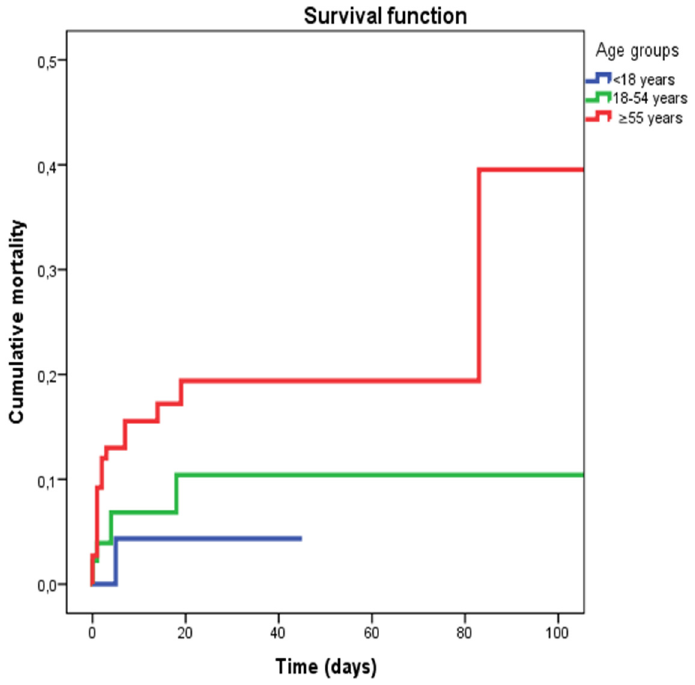
Figure 1. Survival function among the three age groups.